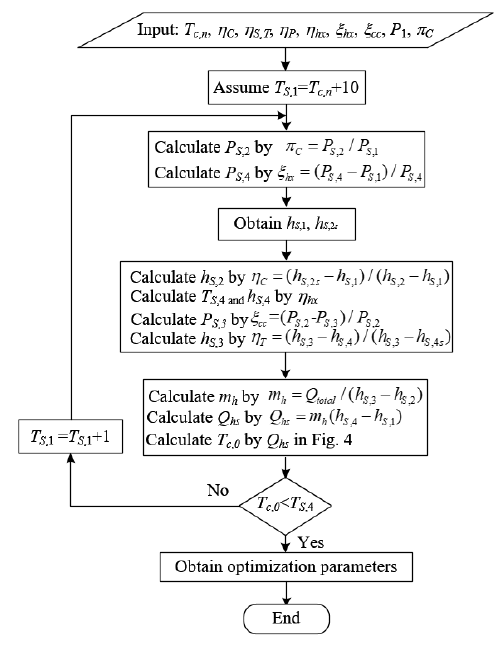
Figure 5. System scheme design process.